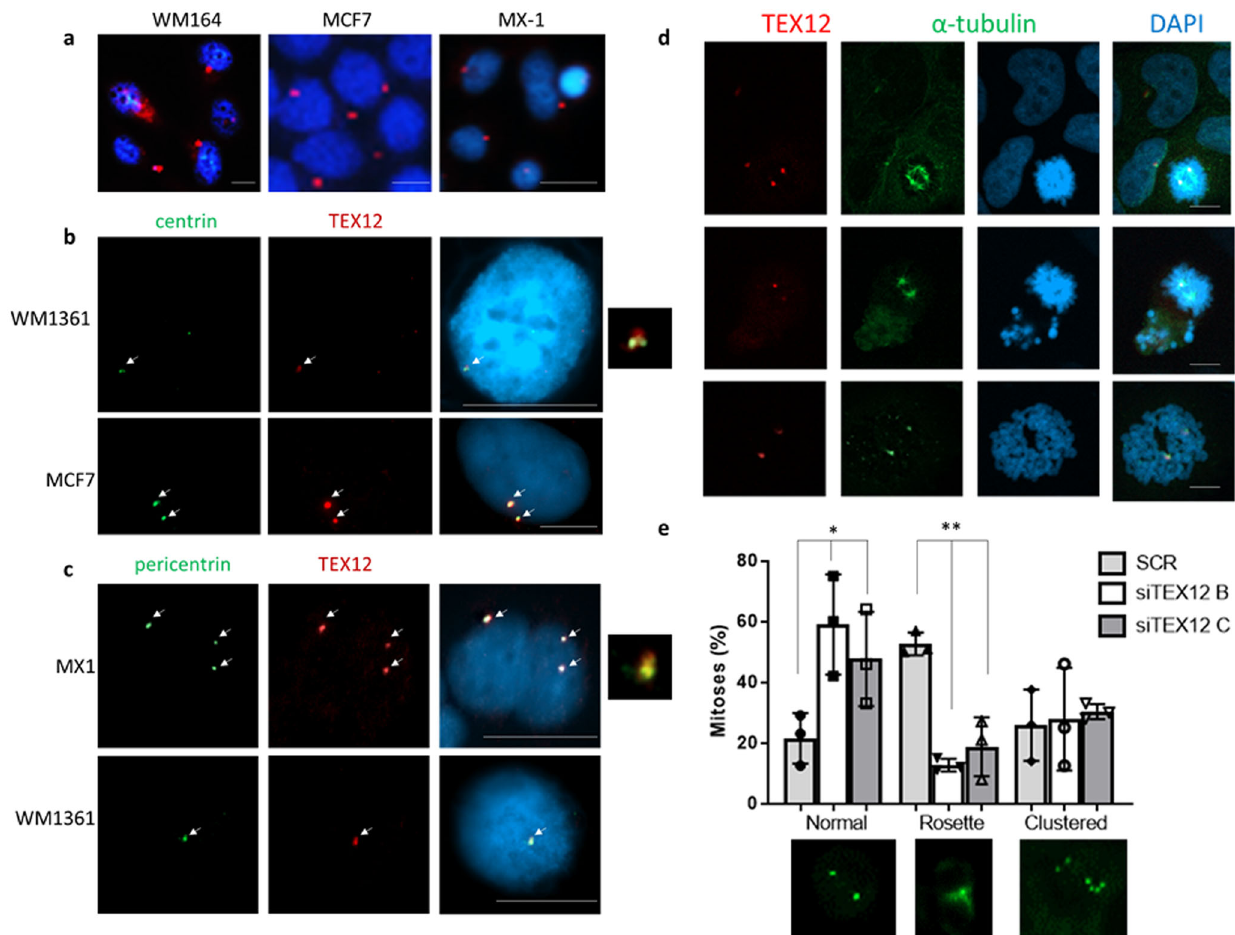
Fig. 1 TEX12 is a centrosomal protein in cancer. a Cells were stained for TEX12 visible in red with DAPI visible in blue. Bar = 20 µ m. b Cells were stained for TEX12 (red), centrin (green) and nuclei were visualised in blue with DAPI. Arrows indicate centrosomes. Bar = 20 µ m. c Cells were stained for TEX12 (red), pericentrin (green) and nuclei were visualised in blue with DAPI. Arrows indicate centrosomes. Bar = 20 µ m. d Dividing PC3 cells stained for TEX12 visible in red, α -tubulin visible in green and DAPI visible in blue. Bar = 20 µ m. e Cancer cells were treated with non silencing control (CTR) siRNA, siTEX12 B or siTEX12 C for 96 h followed by centrin staining in green. Mitosis types were quanti fi ed in 200 cells from three independent experiments. * p < 0.05; *** p < 0.005. Error bars represent standard